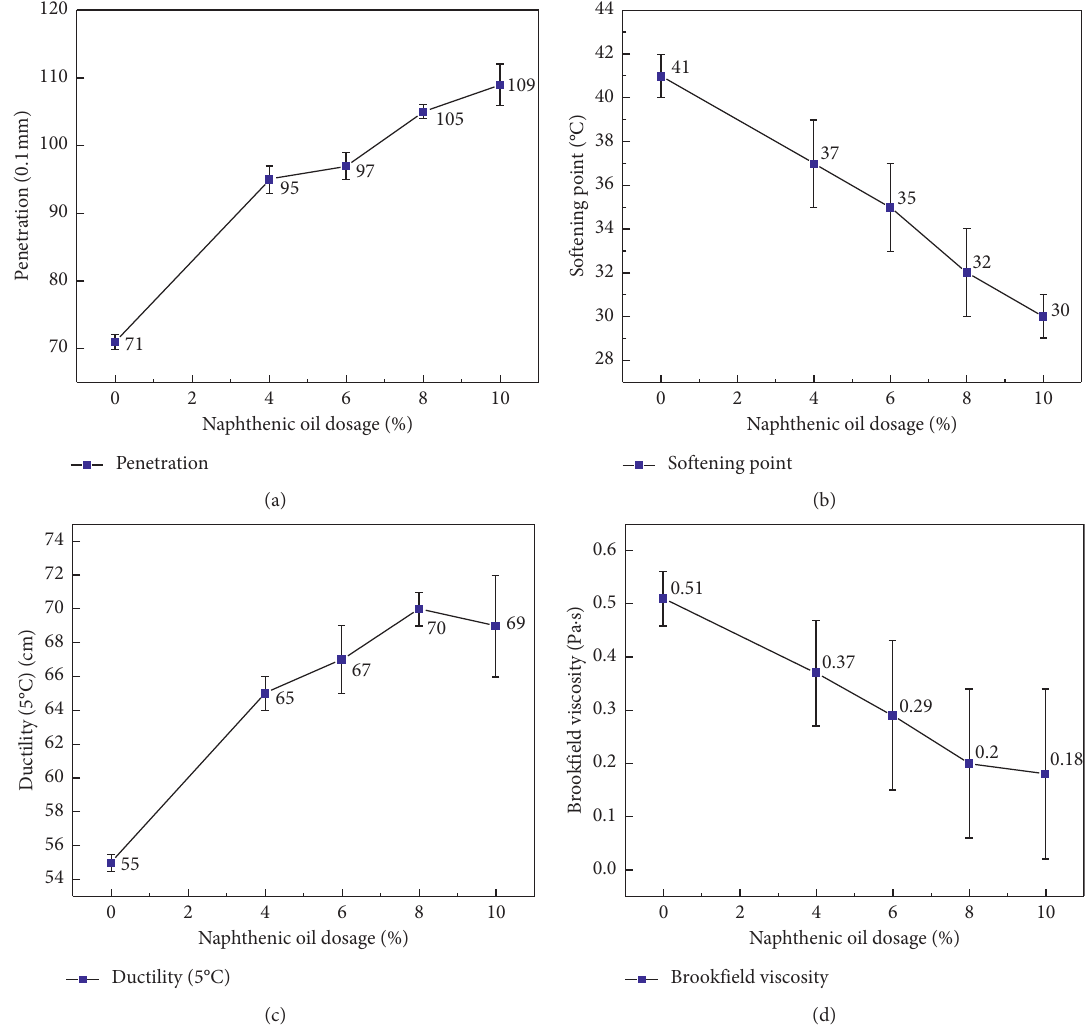
Figure 3: Single factor test results of naphthenic oil variation. (a) Penetration test results. (b) Softening point test results. (c) Ductility test results. (d) Brookfield viscosity test results.